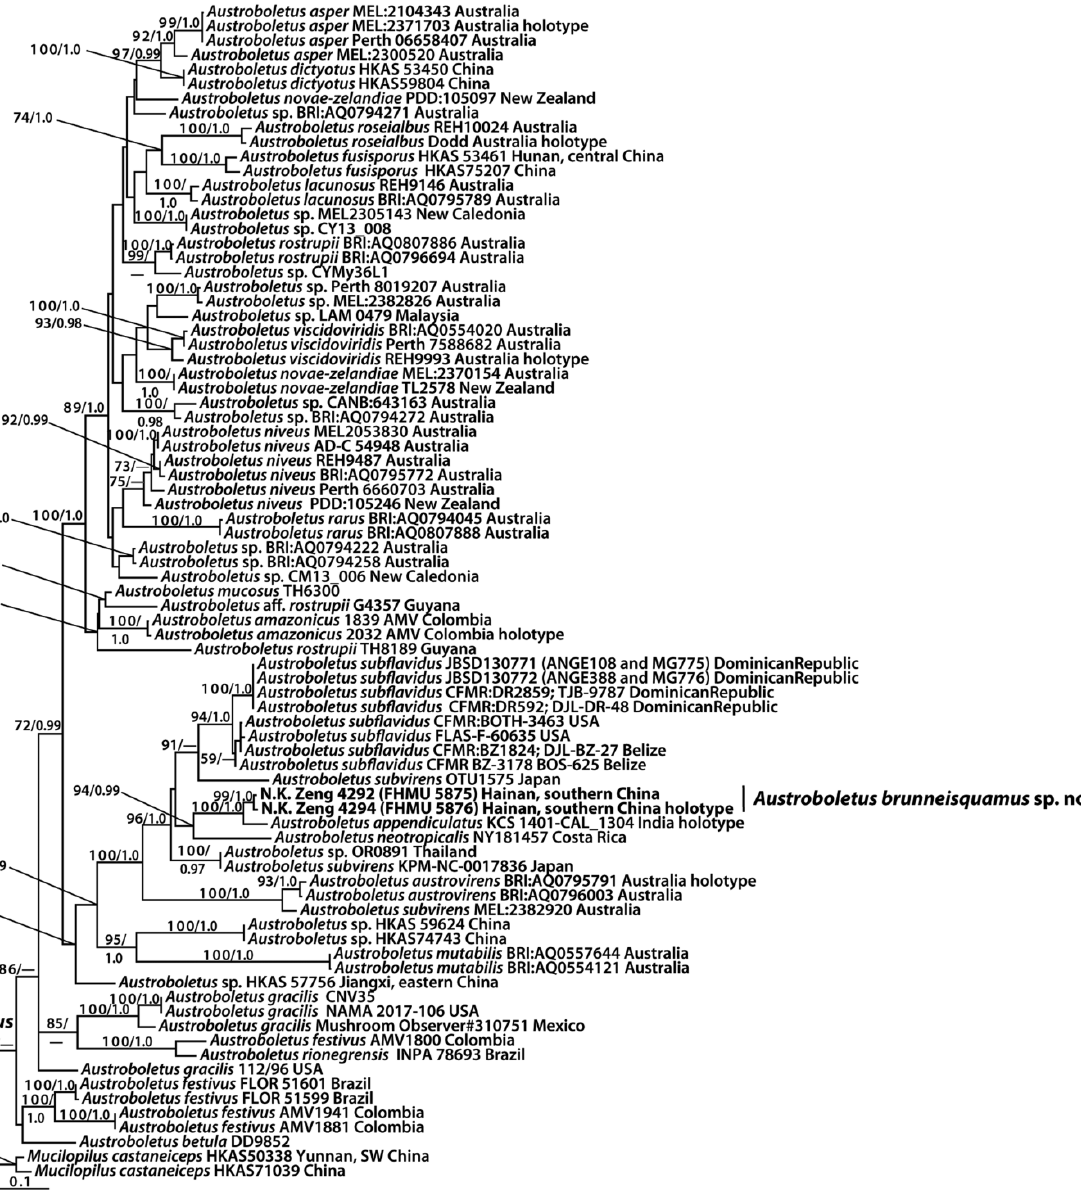
Figure 1. Phylogram inferred from a combined dataset (28S, ITS and TEF1 ) using RAxML. RAxML likelihood bootstrap (BS ≥ 50%) and Bayesian posterior probabilities (PP ≥ 0.95) are indicated above or below the branches as RAxML BS/PP.